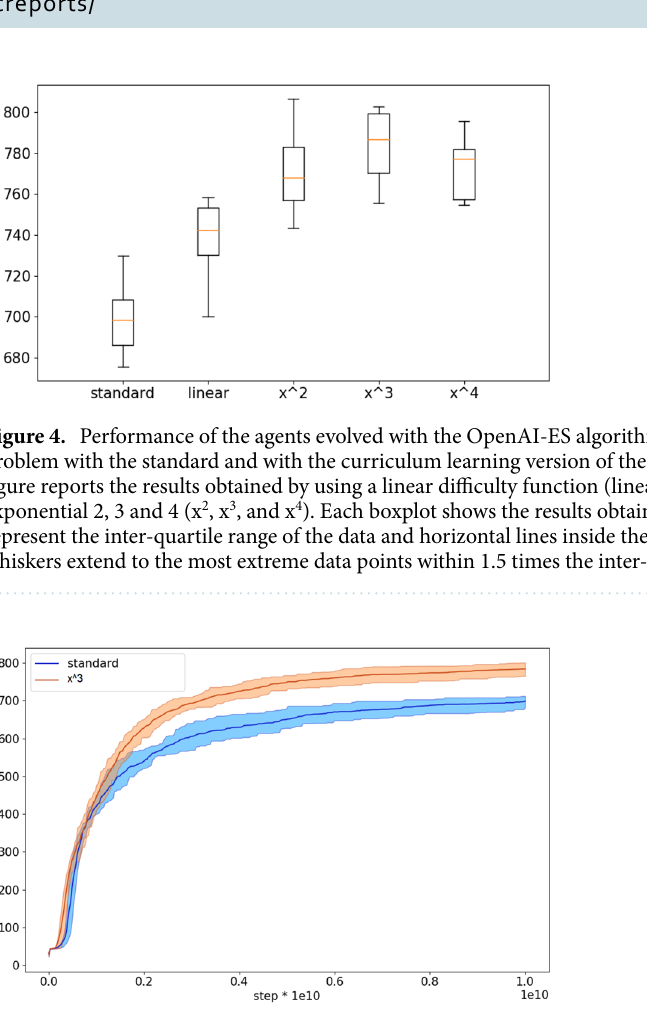
Figure 5. Performance during the evolutionary process of the agents evolved with the standard and with curriculum learning OpenAI-ES algorithm. The latter data refers to the experiments performed with the cubic difficulty function. Each curve shows the average results of 10 replications. The shadow indicate the 90% bootstrapped confidence